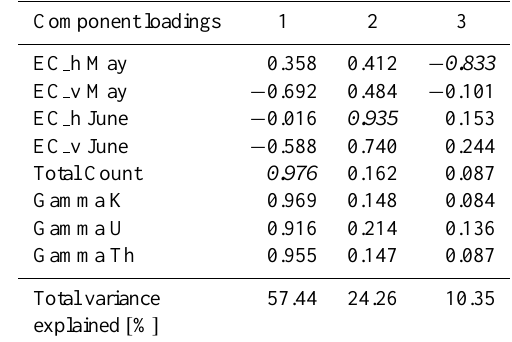
Table 2. Results of the PCA: the Component Loadings shows the variance of each variable explained by three factors. Maximum vari- ances of the selected variables for cluster analysis are explained by different factors (italic). Below the respective percentage of the three factors which explain altogether 92% of total